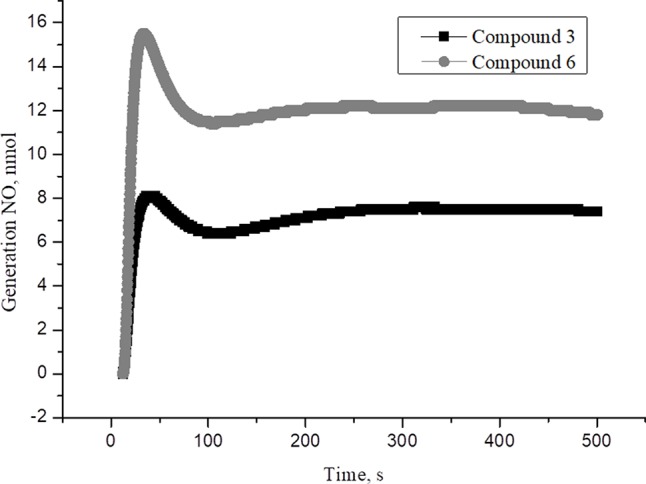
The time dependence of NO amount generated by DNIC#3 and DNIC#6 in aqueous solutions at pH 7 and T = 25 °C under anaerobic conditions. The DNICs concentration was (2 × 10-4 M). The values presented are the means ± SD of three independent experiments, n = 3.